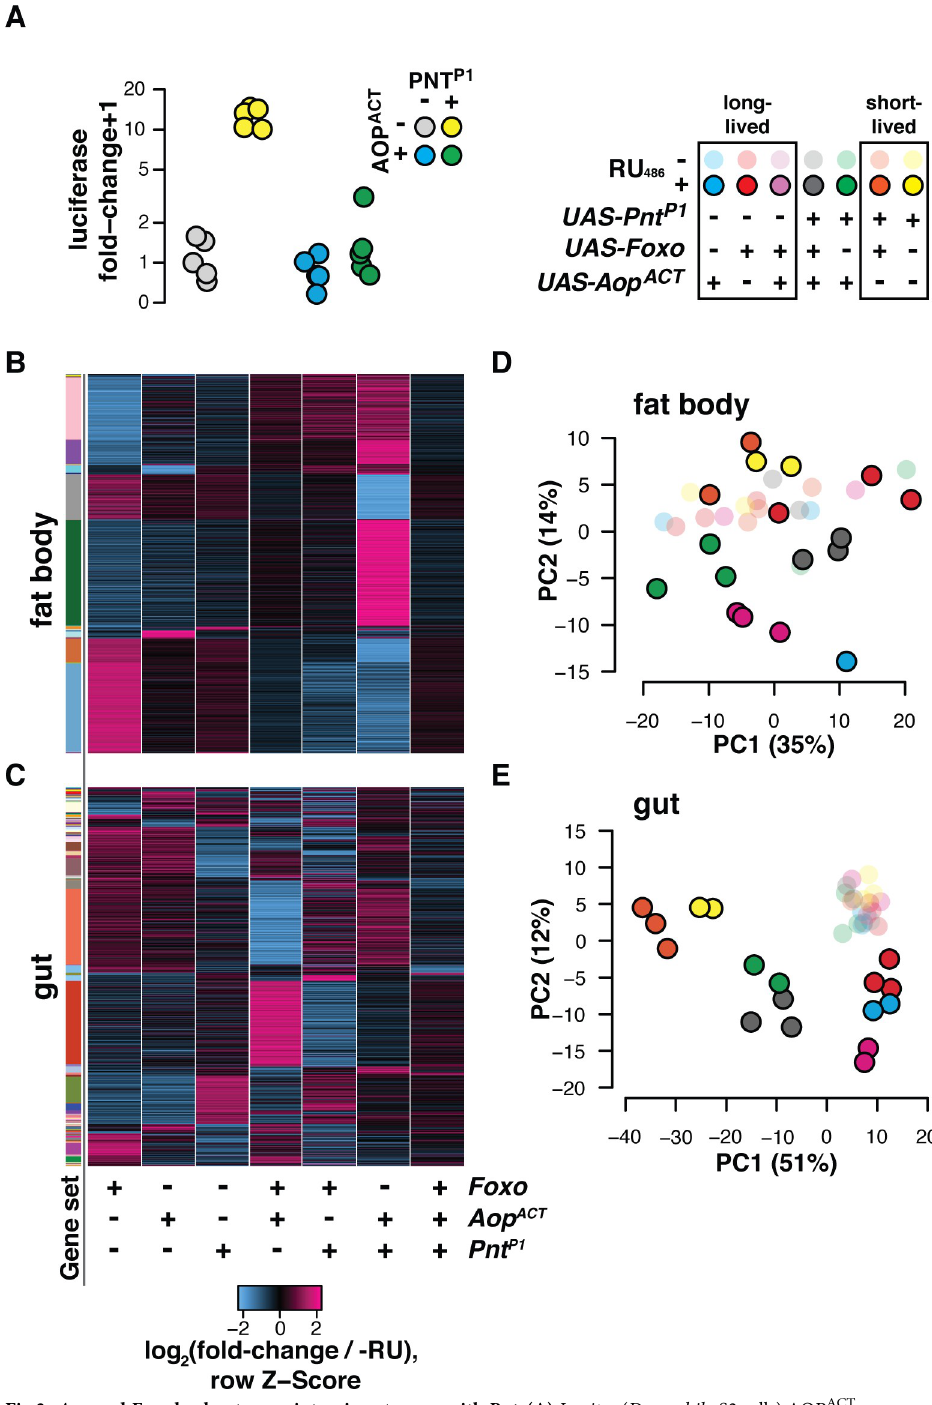
Fig 3. Aop and Foxo broker transcriptomic outcomes with Pnt . (A) In vitro ( Drosophila S2 cells) AOP ACT counteracts activation by PNT P1 of a synthetic promoter containing EBMs, upstream of an Adh-Firefly luciferase reporter. Activity is shown following normalisation to internal Renilla luciferase controls, and calculation of fold-change over median expression in the absence of PNT P1 and AOP ACT . Promoter activation was subject to a significant AOP ACT : PNT P1 interaction (linear model F 1,16 = 41.725, p = 7.9e-6) (B-C) Foxo and Aop ACT coordinate transcription by jointly countering Pnt ’s transcriptional output. Heatmaps show per-gene Z-score of log 2 fold-change expression (DESeq2 output) upon RU 486 feeding relative to controls. Rows represent all genes in the union of targets identified in flies